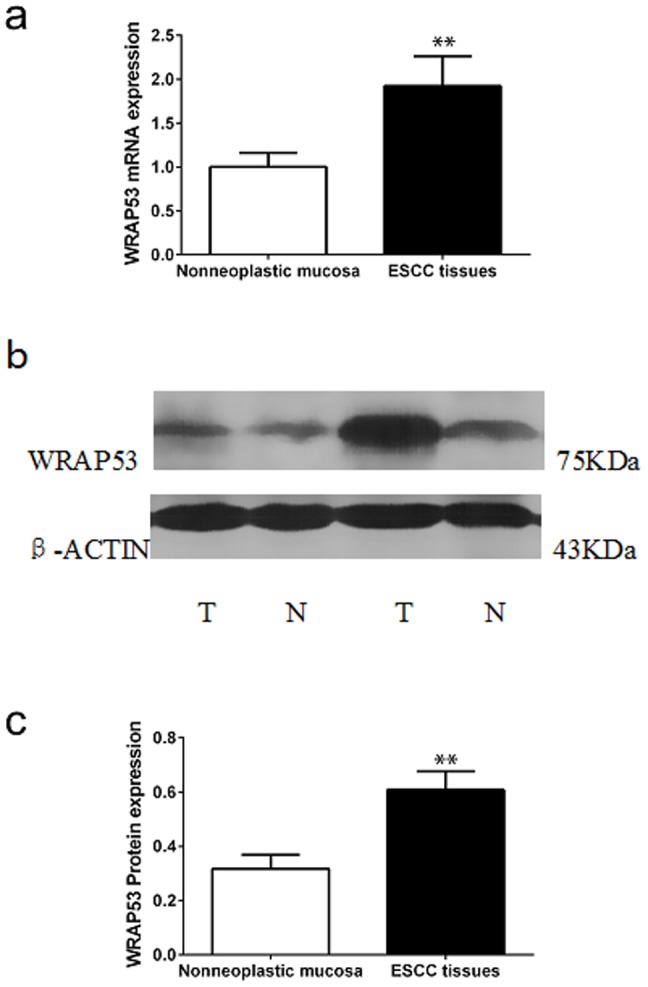
mRNA and protein expression of WRAP53 in ESCC and non-neoplastic tissues.(a) Relative expression of WRAP53 mRNA in ESCC tissues and non-neoplastic mucosa. GADPH was used as an internal control gene in the qRT-PCR. (b) Western blot analysis of WRAP53 protein expression in esophageal carcinoma tissues and non-neoplastic mucosa tissues. Representative blots are shown for the 75-kDa WRAP53 protein. The upper panel is representative of two paired ESCC tissues (marked “T”) and their corresponding non-neoplastic esophageal mucosa tissues (marked “N”); β-actin was used as a control. (c) Densitometric values were determined by normalization to β-actin protein levels. **p<0.01.